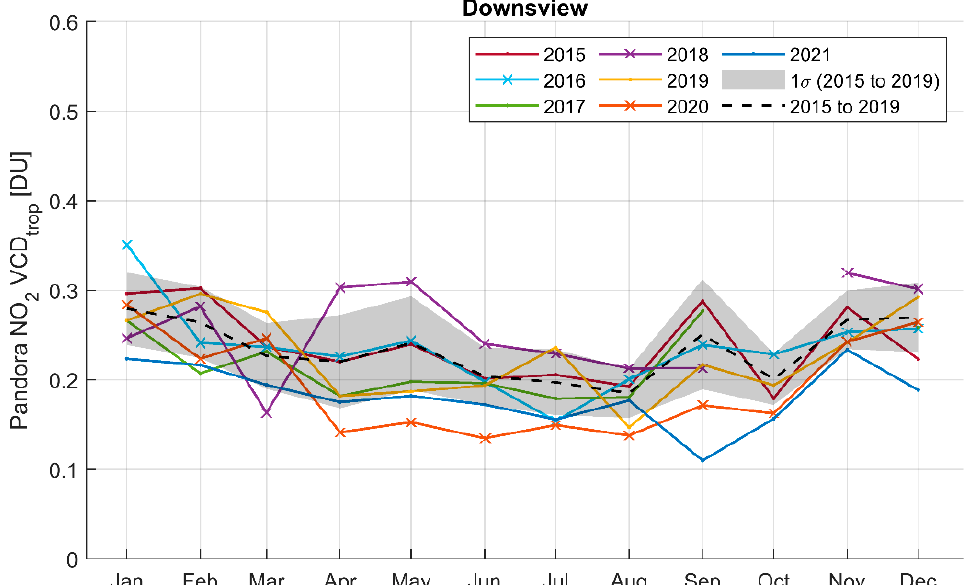
Figure 2. Time series of monthly NO 2 tropospheric column at Downsview site. The black dashed line is the mean of observations from 2015 to 2019, with the shading area representing the standard deviation of the 5-year mean.